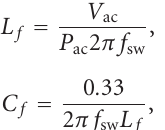
Table 1: Simulation